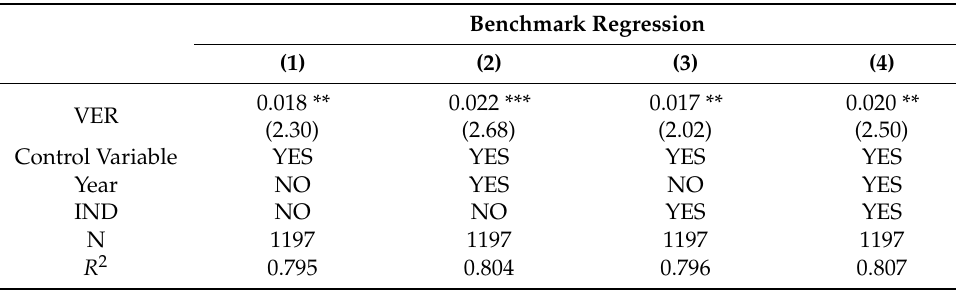
Table 3. Benchmark regression results.